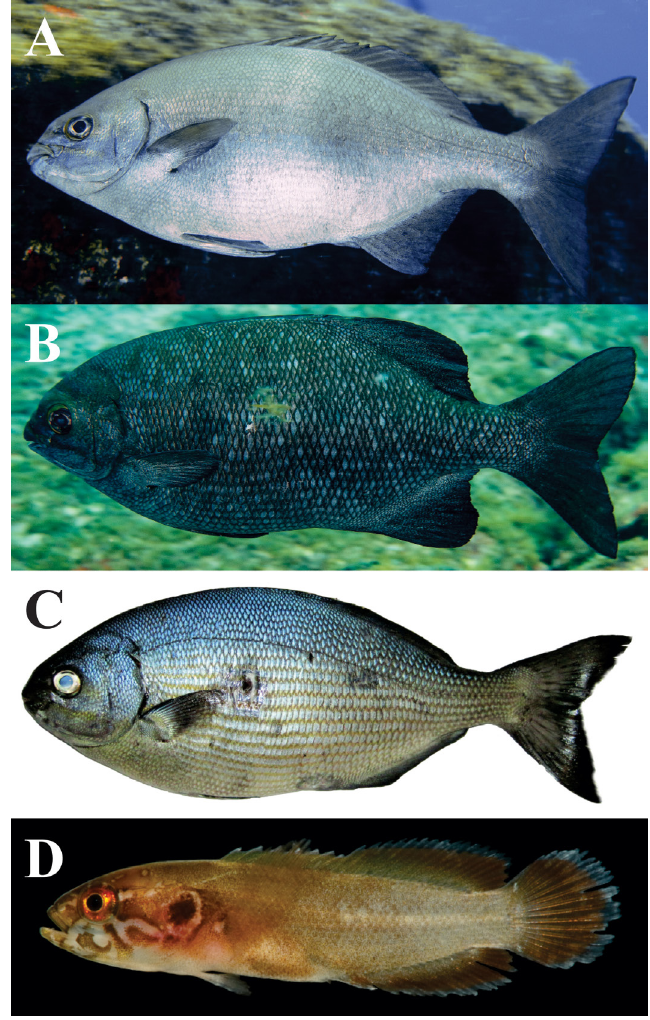
FIGURE 6 | New records of fishes from the euphotic ecosystems. A. Kyphosus bigibbus (~ 25 cm total length); B. Kyphosus cinerascens (~ 25 cm total length); C. Kyphosus vaigiensis (~ 25 cm total length; CIUFES 4050); and D. Pseudogramma gregoryi (~ 6.5 cm total length; CIUFES 4029). Photos A , B and C by J. L. Gasparini and photo D by R. M. Macieira. Apogon pseudomaculatus (CIUFES 3957) is not shown.